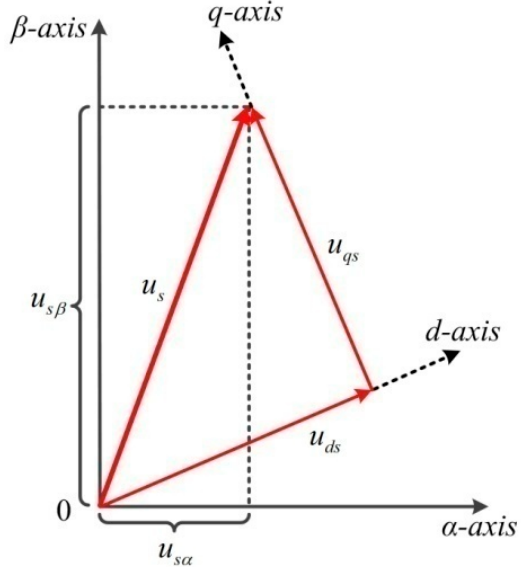
Figure 3. Synthesis voltage vectors in d-q reference frame.